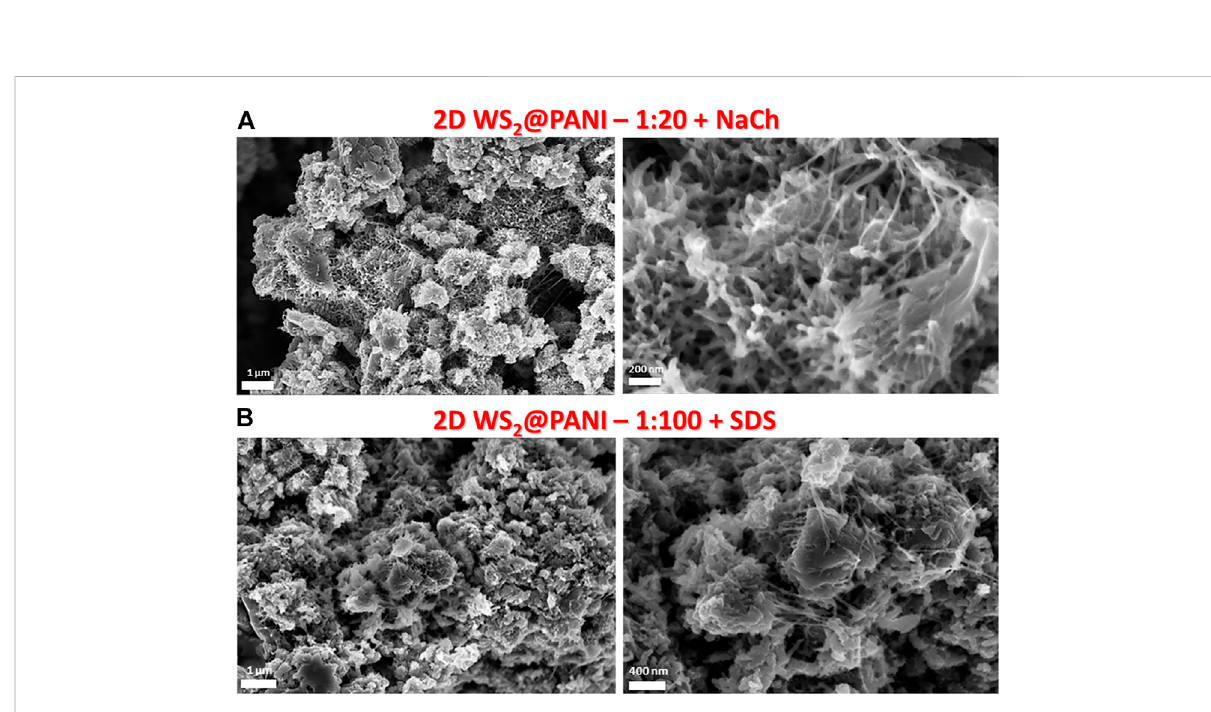
FIGURE 2 SEMimagesatdifferentmagni fi cations ofprototypical nanostructured2DWS 2 @PANInanohybrids obtained with differentLPEWS 2 /PANI molar ratios and with different surfactants favouring the proper mixing of the two individual components in the composite. (A) 2D WS 2 @PANI with 1: 20molarratiopreparedinthepresenceofNaChassurfactant. (B) 2DWS 2